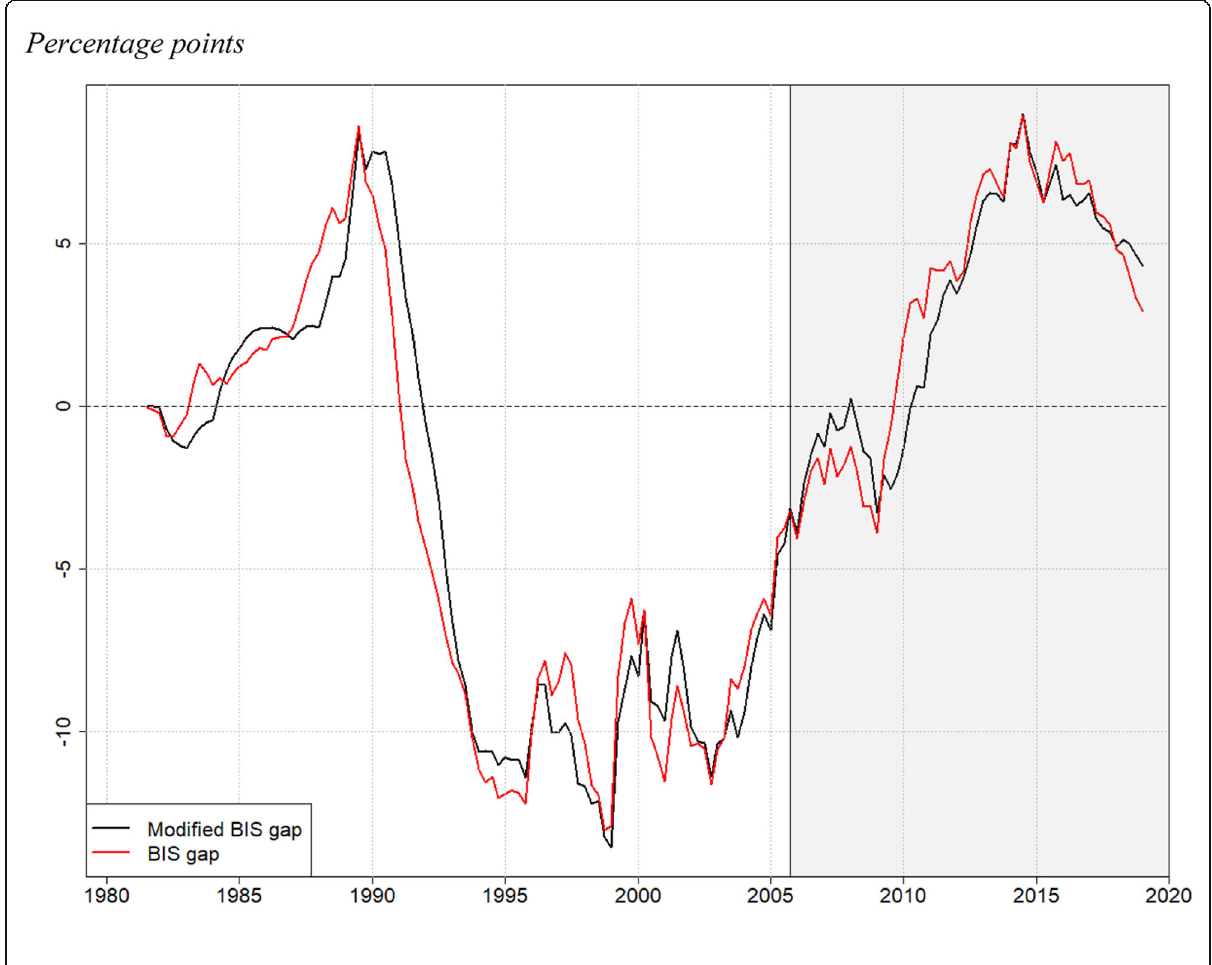
Fig. 8 Real-time evolution of the modified BIS gap and BIS gap between 2005 and 2018. Percentage points